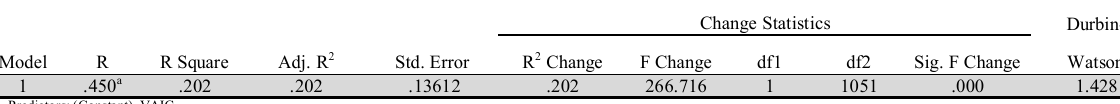
Model Summary Model